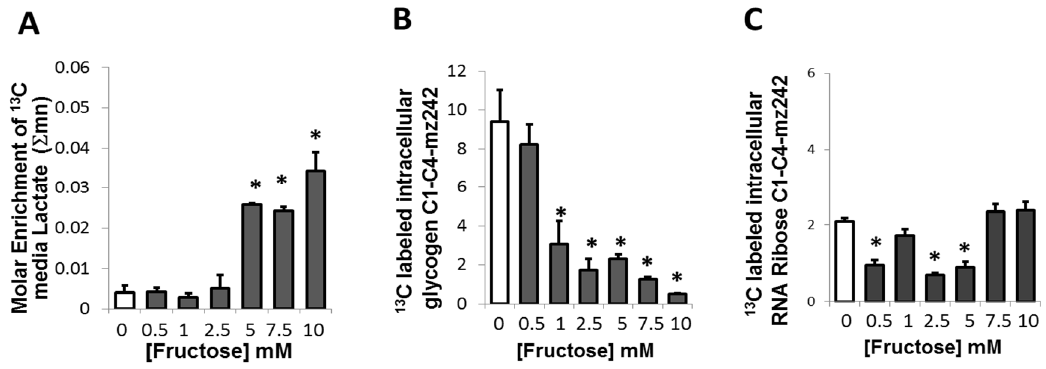
Figure 3. 13 C Glucose-derived media lactate, intracellular glycogen and intracellular